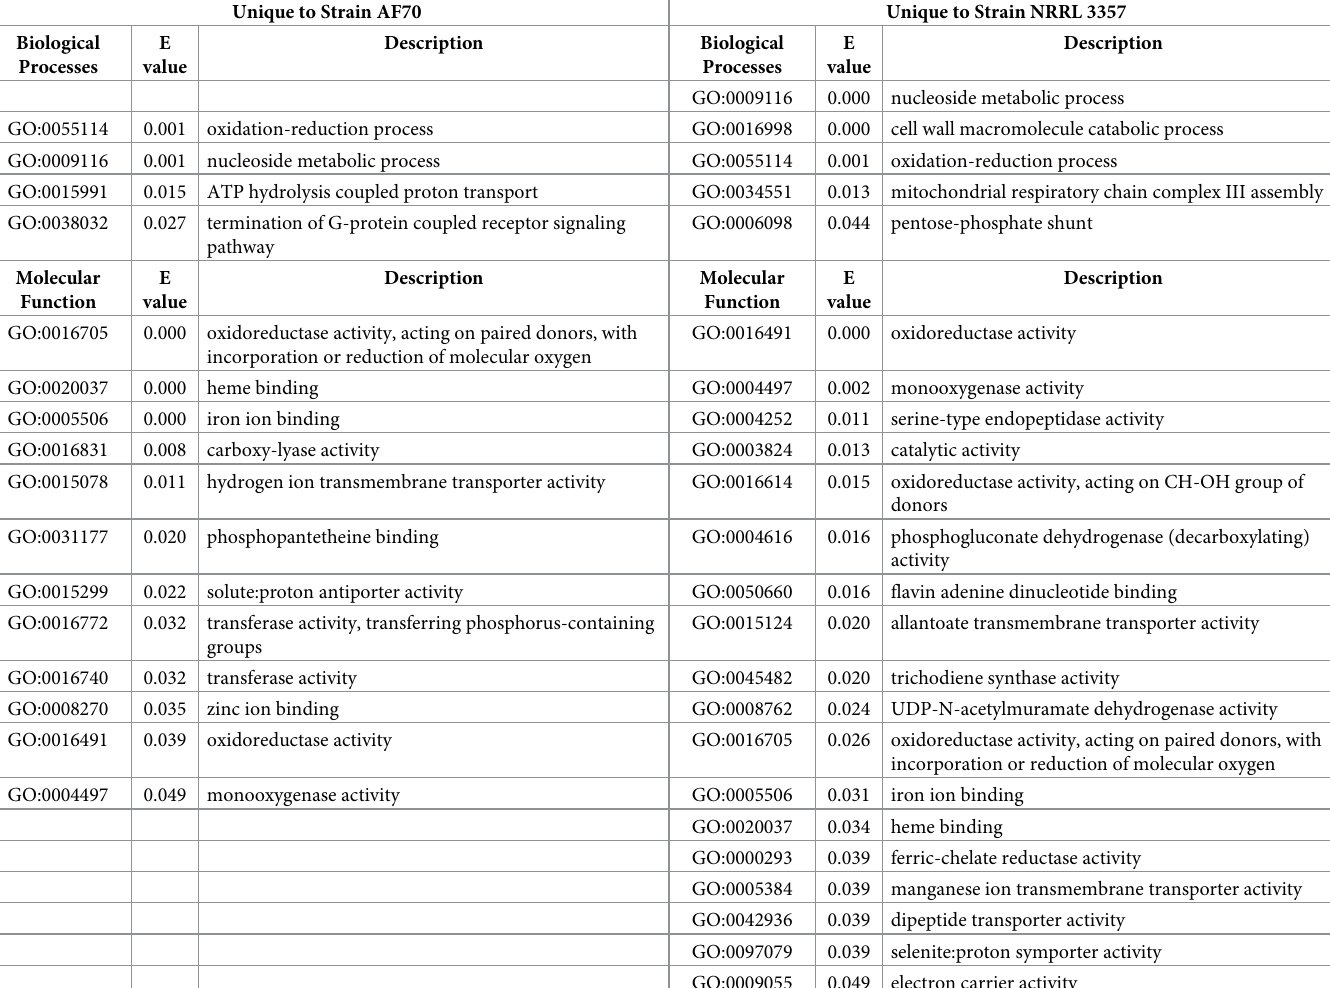
Table 1. Gene Ontology categories of genes that are significantly enriched in strain AF70 and NRRL 3357. Unique to Strain